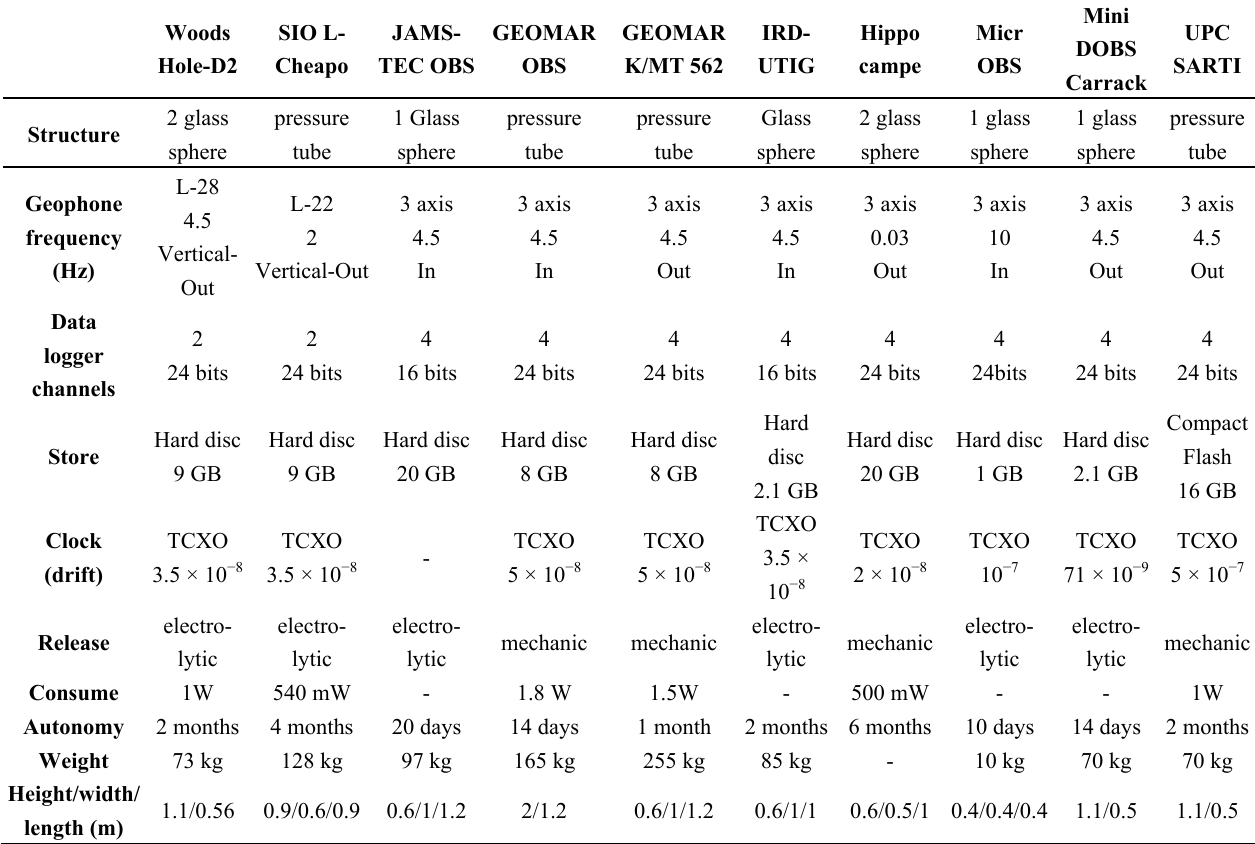
Table 1. Comparative of present Ocean Bottom Seismometers.